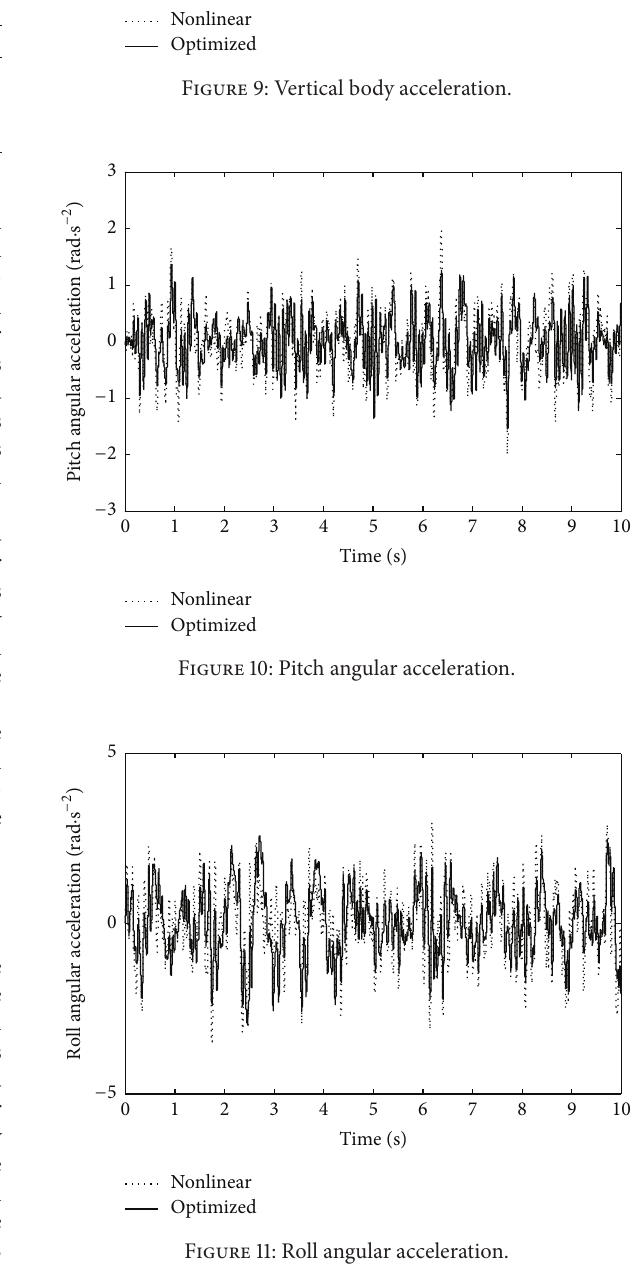
Figure 11: Roll angular